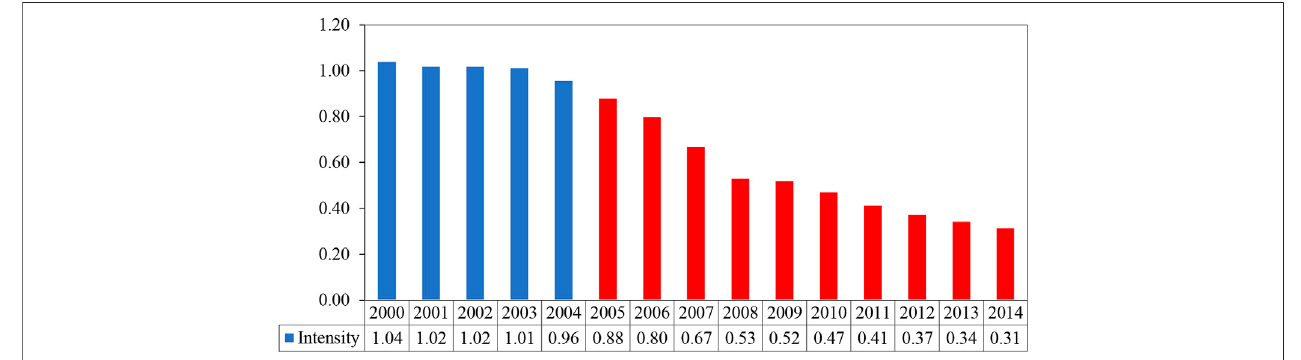
FIGURE 6 | Weighted direct production emission intensity of China ’ s domestic industry during 2000 –